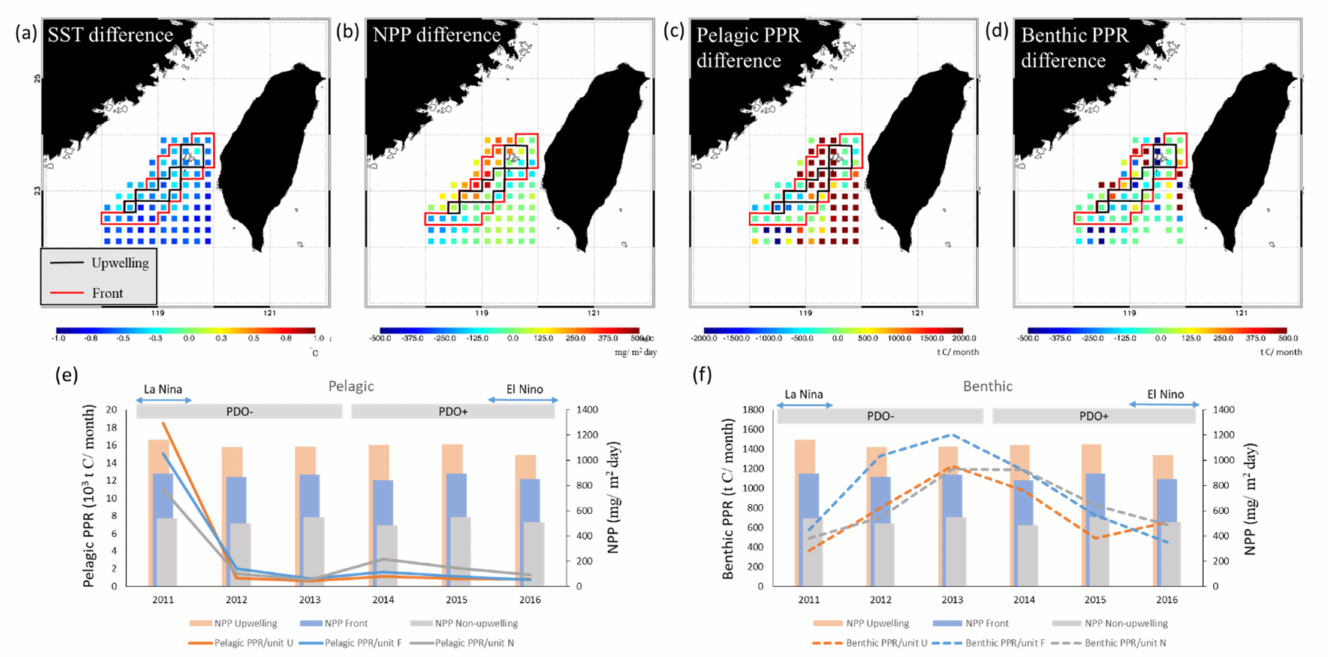
Figure 10. Comparison of differences in the annual average ( a ) sea surface temperature (SST), ( b ) net primary production (NPP), ( c ) pelagic primary production required (PPR), and ( d ) benthic PPR in the Taiwan Bank region during the La Niña (2011) and El Niño (2016) events, as shown in spatial images and ( e ) Pelagic, and ( f ) Benthic PPR with NPP time series. The black and red boxes represent the upwelling and frontal habitats,